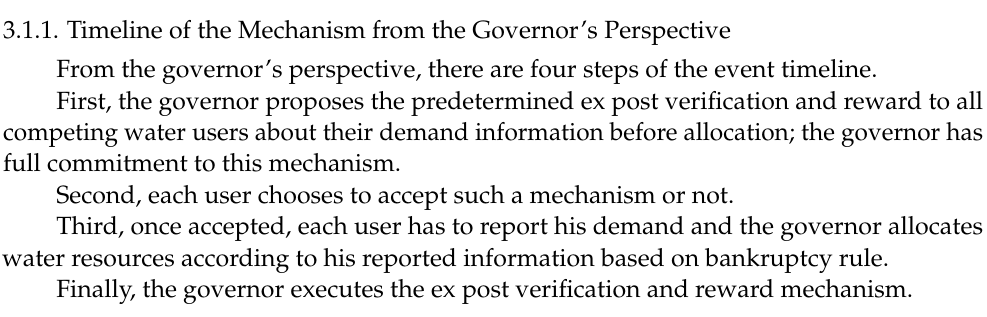
Figure 2. Timeline of the mechanism from user i ’s